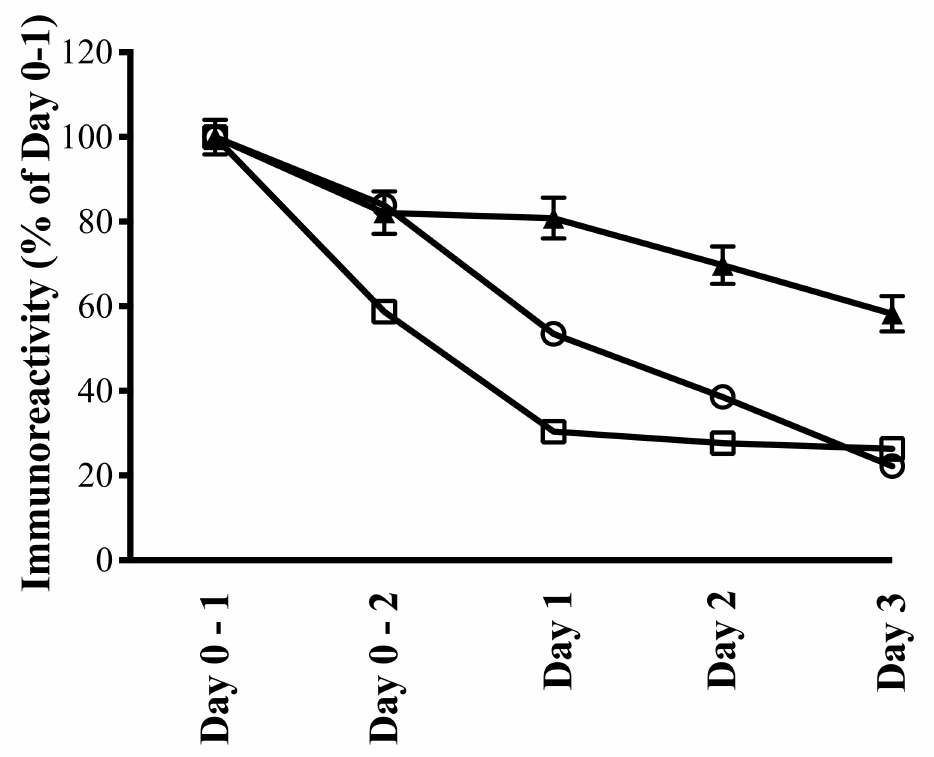
Figure 3. Change in IgG and some growth factor constituents within BC during the first few days post-calving. BC was collected at the first and second milking on day 0, and daily for the following 3 days from 6 cows post-calving, i.e., Day 0-1 and 0-2 samples were both collected on the first day after calving. Samples were analysed for IgG and growth factor concentrations using commercial ELISA kits. Immunoreactivity is expressed as % of Day 0-1 sample. EGF ( (cid:78) ), IGF1 ( (cid:3) ) and IgG ( Results are expressed as mean ± SEM of 6 animals per time point, with each sample measured in triplicate. The concentrations of all constituents shown were significantly reduced in each subsequent collection, p < 0.01 vs. their Day 0-1 value. Adapted from